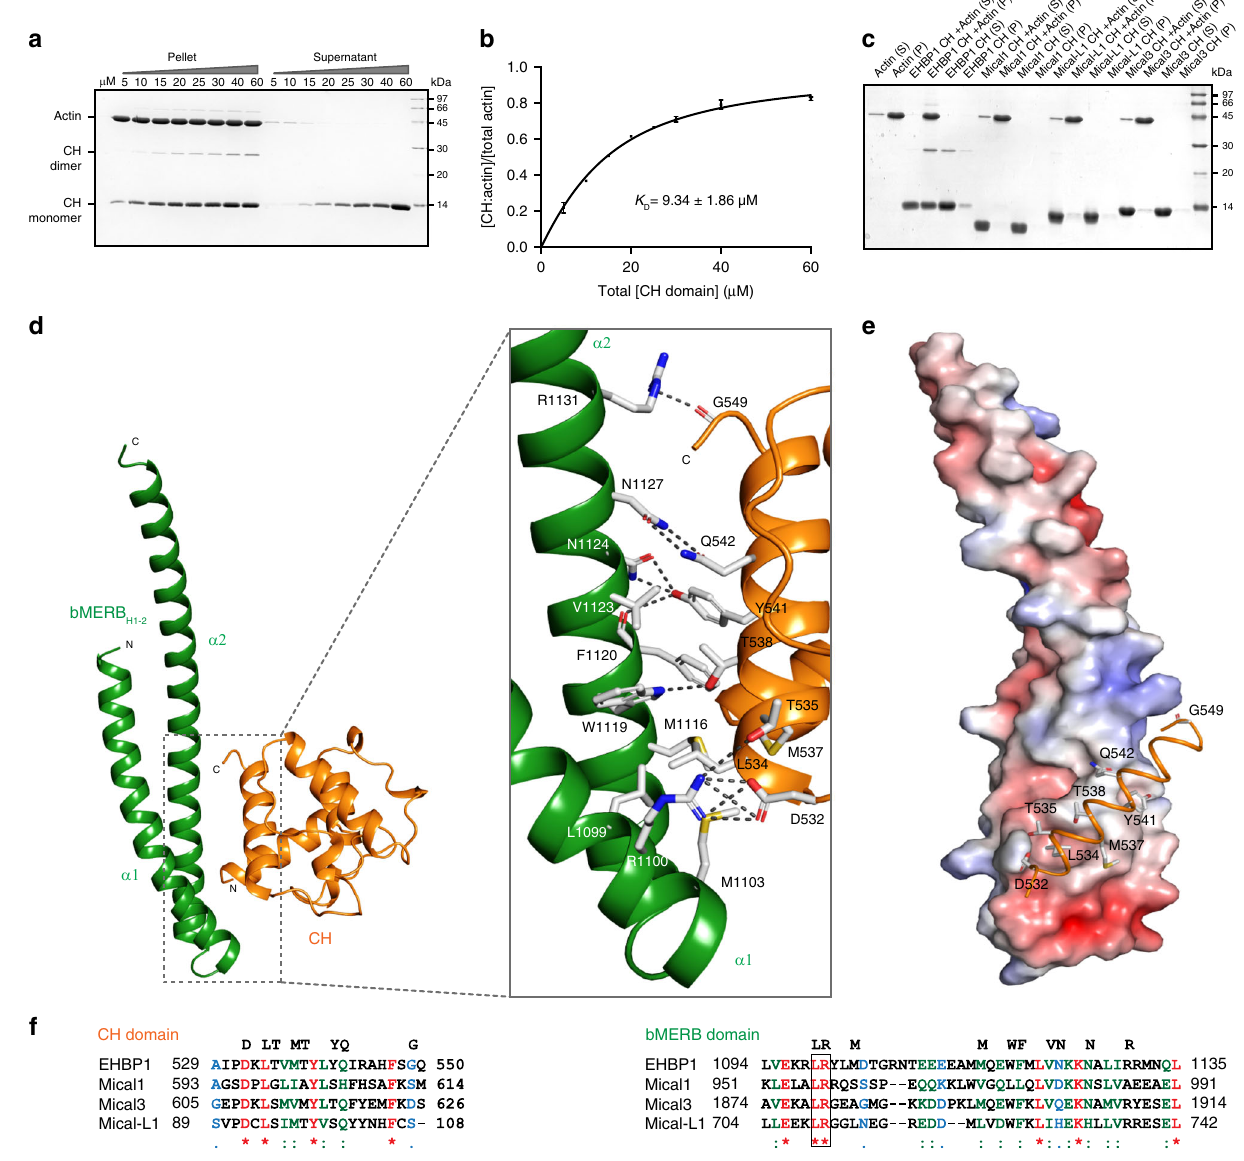
Fig. 4 CH domain interaction with F-actin and structure of the EHBP1 CH:bMERB H1-2 complex. a The EHBP1 CH domain co-sediments with F-actin fi laments in vitro. SDS-PAGE of pellets and supernatants from high-speed centrifugation performed at a fi xed concentration of F-actin (10 µ M) and with varying concentrations of the EHBP1 CH domain (0 – 60 µ M) is shown. b The normalized fraction of F-actin bound EHBP1 CH domain as a function of total EHBP1 CH domain concentration. Values were calculated from densitometry of SDS-PAGE. The data from two technical repeats are shown as means ± s.d. ( n = 2). The error bars are included in the plot but are too small to be displayed on several of the points. c Results of systematic analysis of interactions between the CH domains of different bMERB family members with F-actin via co-sedimentation experiments. Only the EHBP1 CH domain interacts with F- actin. Experiments were repeated at least two times independently with similar results. Source data are provided as a Source Data fi le. d Cartoon representation of the CH:bMERB H1-2 complex structure. The bMERB domain is colored green and the CH domain in orange. The inset shows the zoom-in overview of the CH:bMERB interaction interface. Hydrogen bonds and polar interactions are shown in gray dashed lines. e Surface electrostatic potential of bMERB H1-2 calculated in PyMOL using the APBS-PDB2PQR plugin and visualized in red to blue ( − 5 kT/e to + 5 kT/e). The C-terminal helix of the CH domain is shown. f Sequence alignment of the interacting regions of the CH and the bMERB domain of different bMERB family members. Residues directly involved in the CH:bMERB interactions are shown over the top of sequence alignment and the conserved LR motif is shown in the black